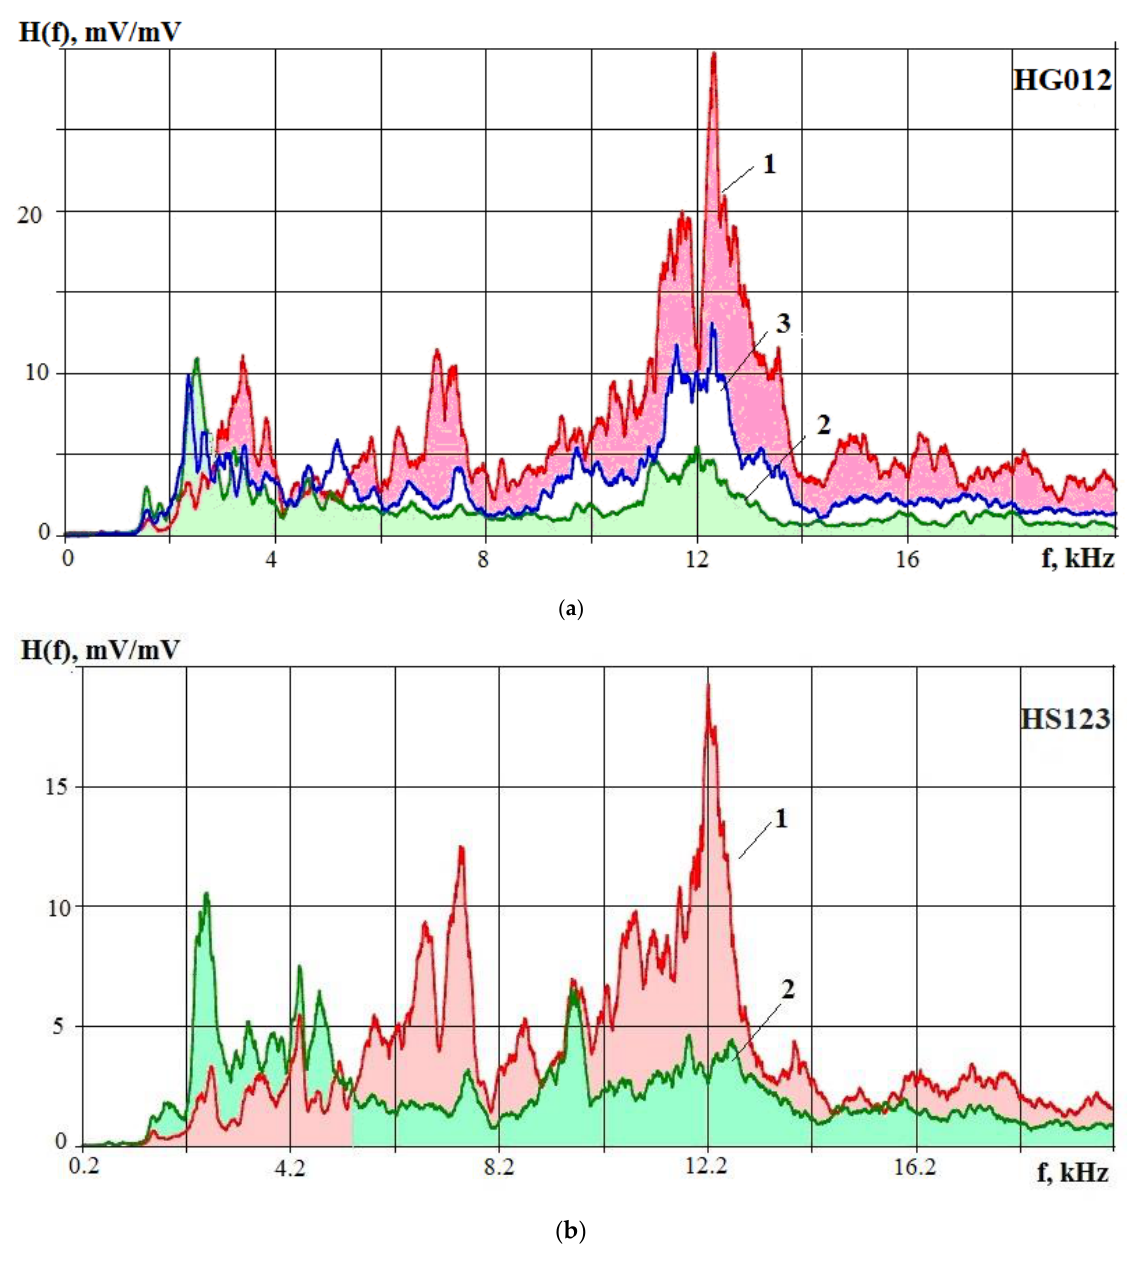
Figure 6. AFC during WEDM of alloys HG012 ( a ) and HS123 ( b ): 1 — AFC at the initial stage of processing; 2 — AFC before wire electrode break; 3 — the intermediate type of AFC.